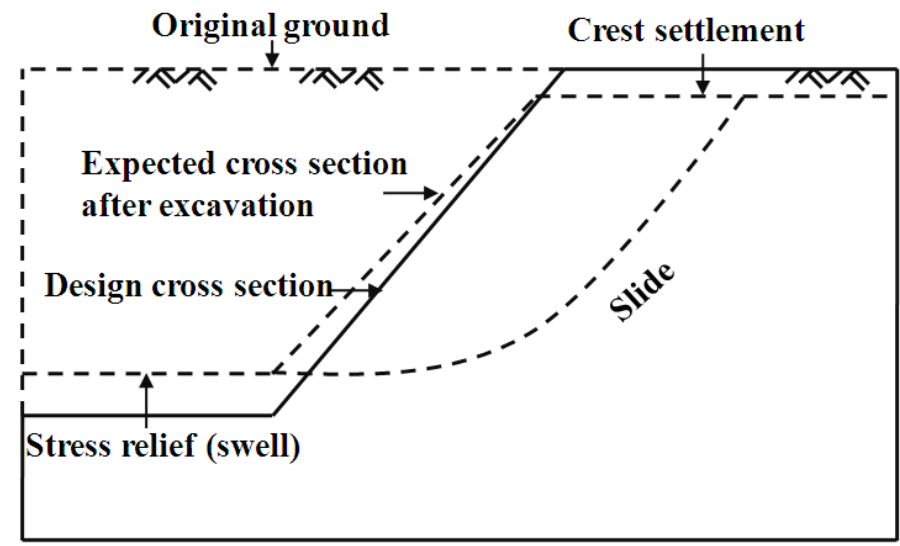
Figure 9. Schematic diagram of displacement after excavation (adapted with permission from Ref. [31]. 2020, J. Mt. Sci.-Engl.).